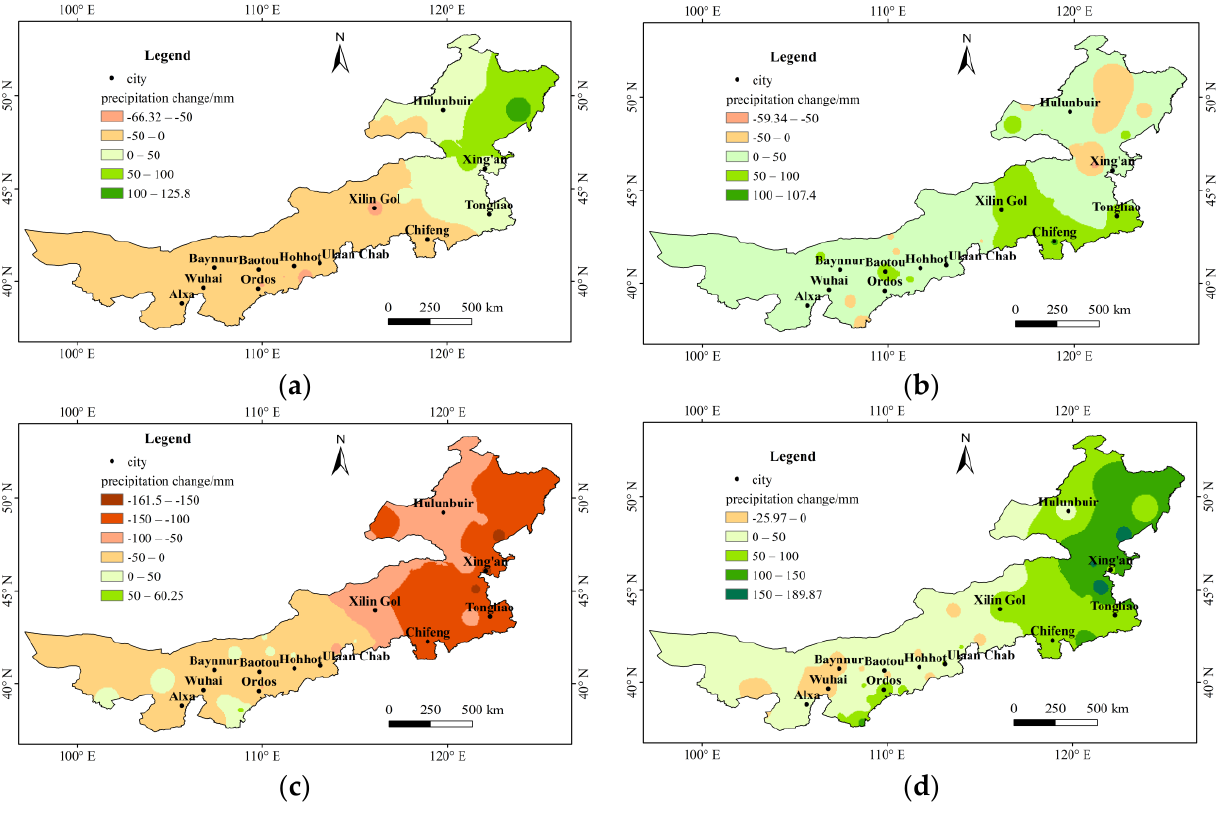
Figure 4. Precipitation changes in Inner Mongolia during different periods. ( a ) Description of precipitation changes in Inner Mongolia in the 1980s and 1970s; ( b ) Description of precipitation changes in Inner Mongolia in the 1990s and 1980s; ( c ) Description of precipitation changes in Inner Mongolia in the 2000s and 1990s; ( d ) Description of precipitation changes in Inner Mongolia from 2011–2017 and in the 2000s.